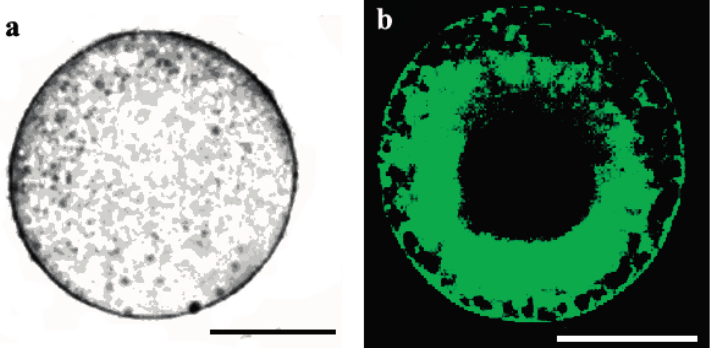
Figure 9. Localization of thapsigargin-sensitive Ca 2+ -ATPase pumps with the green-fluorescent BODIPY FL ® thapsigargin applied at a high (100 µM) concentration. ( a ) Transmission-light micrograph of an egg cell stained with BODIPY FL ® thapsigargin; and ( b ) imaged using a confocal laser scanning (CLSM) microscope. Scale bars are: 21 and 23 µm, respectively.